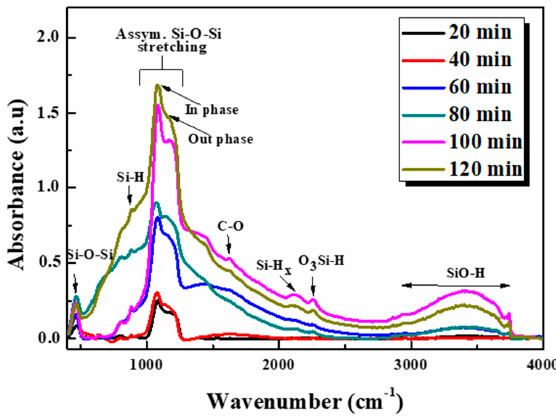
Figure 8. FTIR spectra of SiNWs obtained at different etching time.